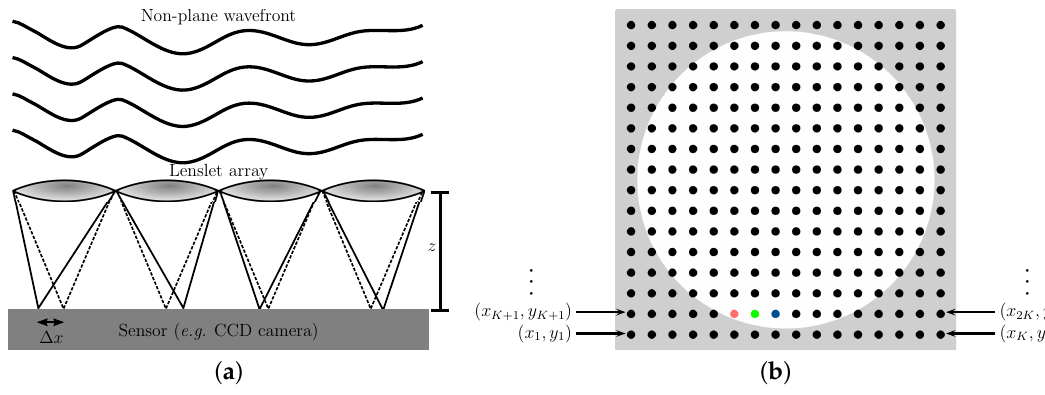
Figure 1. ( a ) Side view of a simplified Shack–Hartmann wavefront sensor scheme; ( b ) top view of the spotfield produced by a perfectly plane wavefront hitting a lenslet